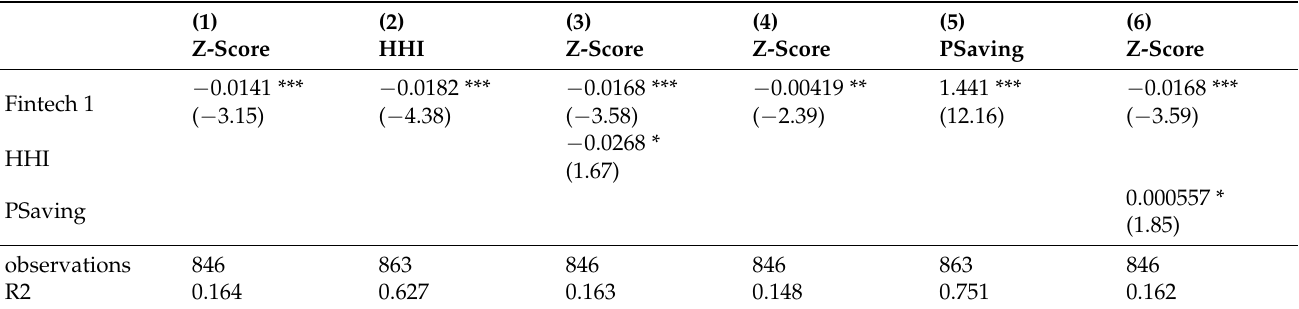
Table 14. Based on the bank’s external intermediary effect